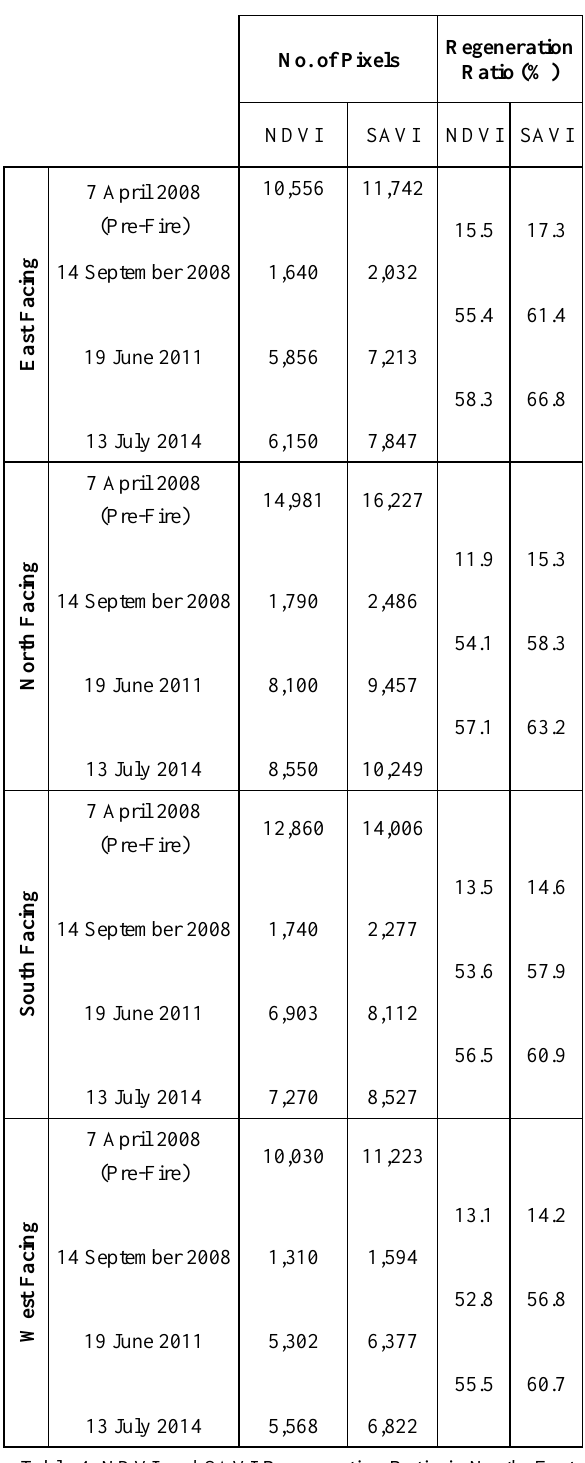
Table 4. NDVI and SAVI Regeneration Ratio in North,